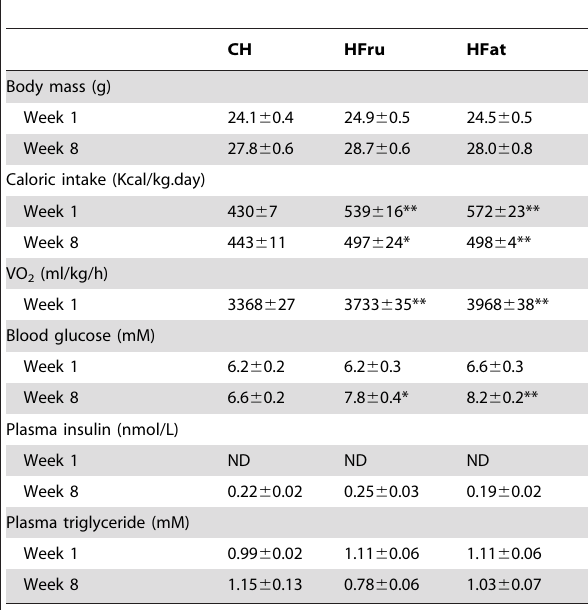
ND, not determined. Data are means 6 SE of 10–15 mice per group. * p , 0.05, ** p , 0.01 vs CH-fed mice. curve (iAUC) of blood glucose, respectively ( p , 0.01 vs CH-fed mice; Figure 2A). To assess the effect of the diets on hepatic insulin signaling proteins, Akt and GSK-3 b , in response to insulin stimulation. As expected, insulin-stimulated Akt phosphorylation